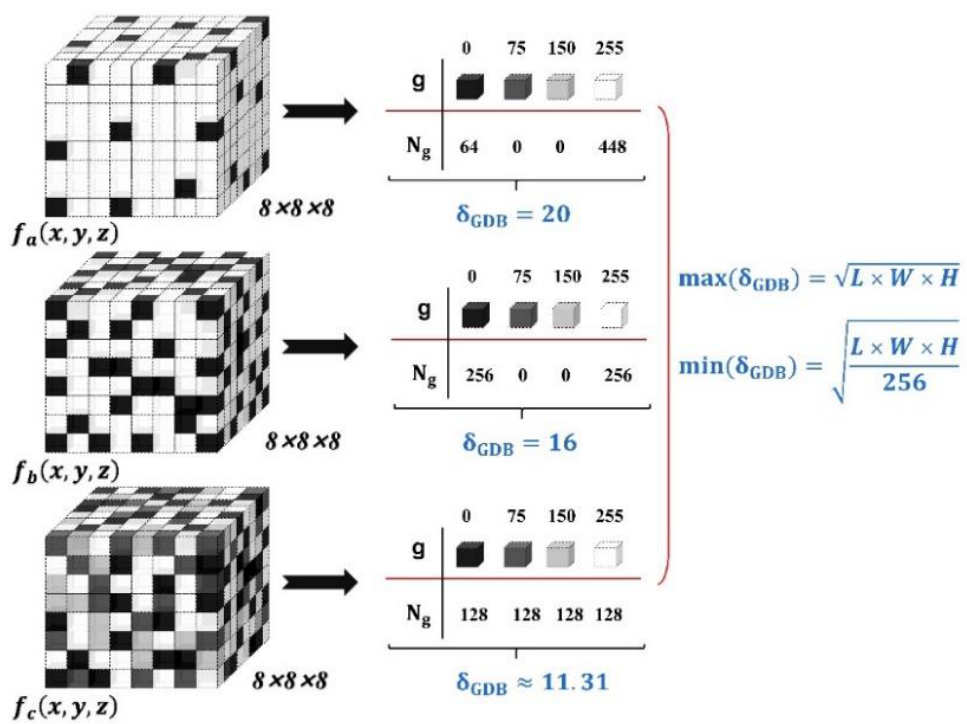
( x , y , z ) , f ( x , y , z ) and f ( x , y , z ) are the schematic diagram corre- a b c